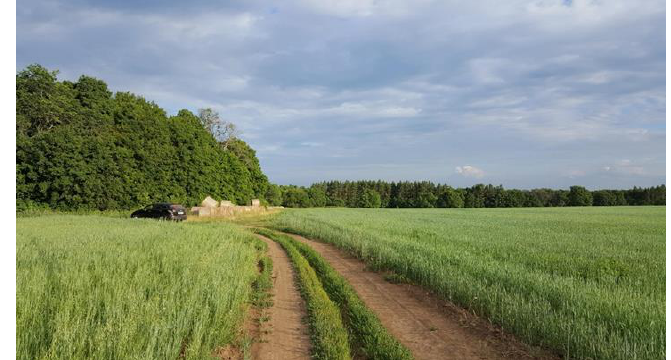
Figure 7. Forestry in the northwest of the site